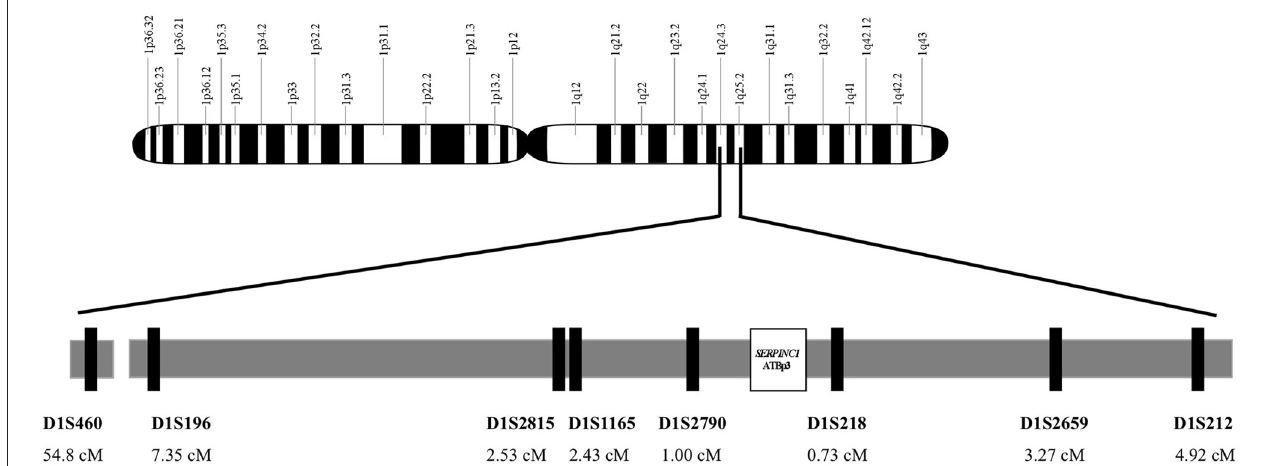
FIGURE 1 | Genomic map of chromosome 1. Localization and position of SERPINC1 gene and the analyzed short tandem repeat markers on region 1q24-25. Short tandem repeat markers are D1S460 (CA) n , D1S196 (AC) n , D1S2815 (CA) n , D1S1165(CTTT) n , and D1S2790 (CA) n locate proximal to SERPINC1 and D1S218 (AC) n , D1S2659 (CA) n , and D1S212(CA) n locate distal to SERPINC1